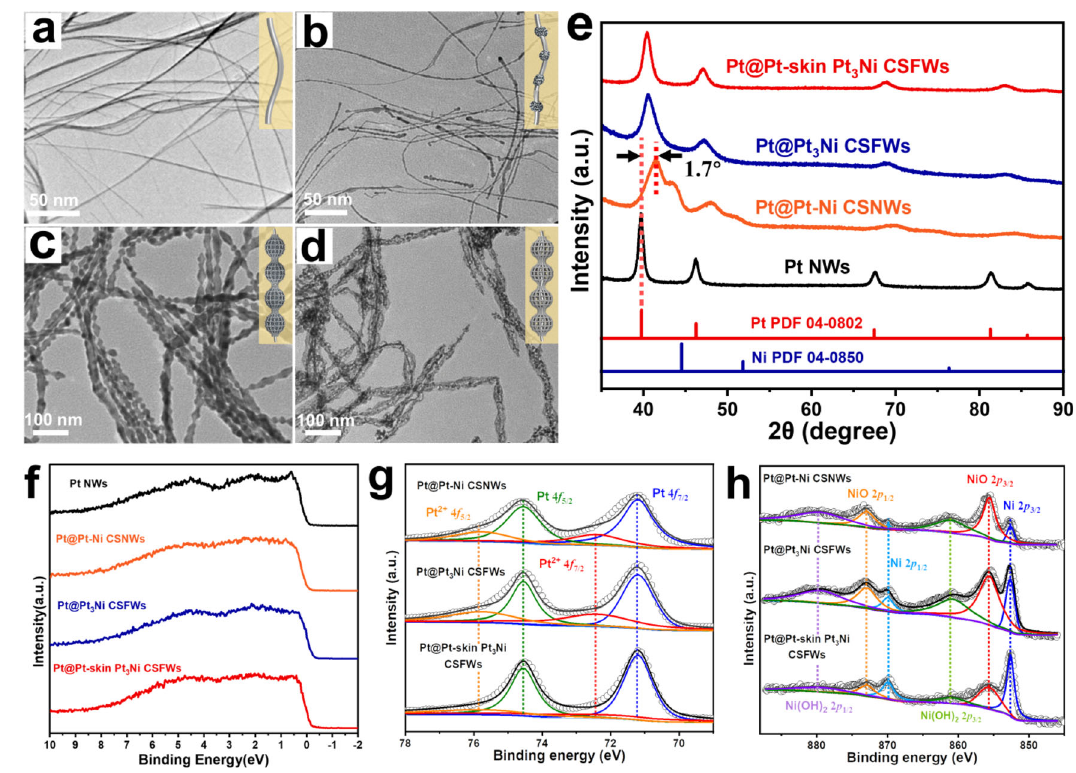
Fig. 2 | Morphological and structural characterizations of various Pt-based samplescollectedfromthereactionsatdifferent stages. TypicalTEM images of a initial ultra fi ne Pt nanowire. b Pt@PtNi nanowire intermediates. c Pt@Pt-Ni alloy CSNWs. d FinalmesoporousPt@Pt-skinPt 3 NiCSFWs. e